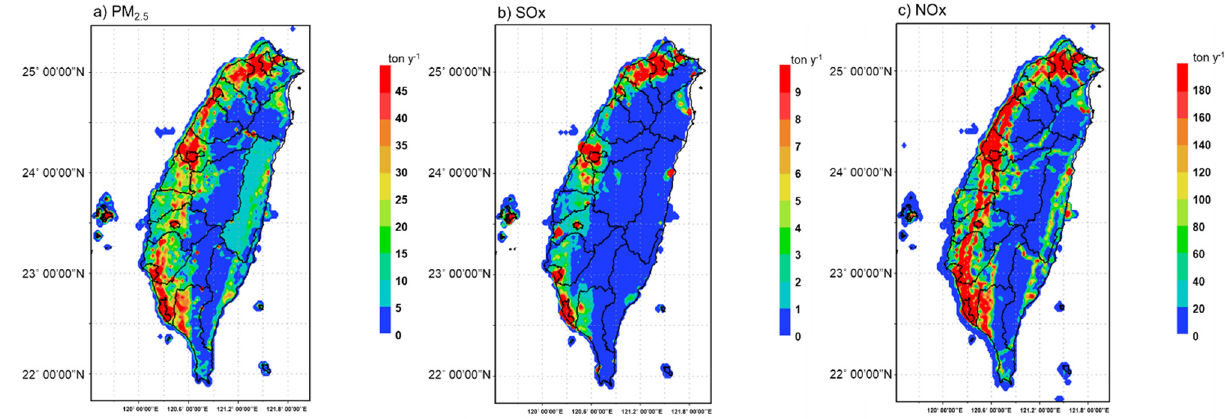
Figure 2. The emission distribution (ton y − 1 ) of PM 2.5 ( a ), SOx ( b ), and NOx ( c ) in the baseline year (scenario I).